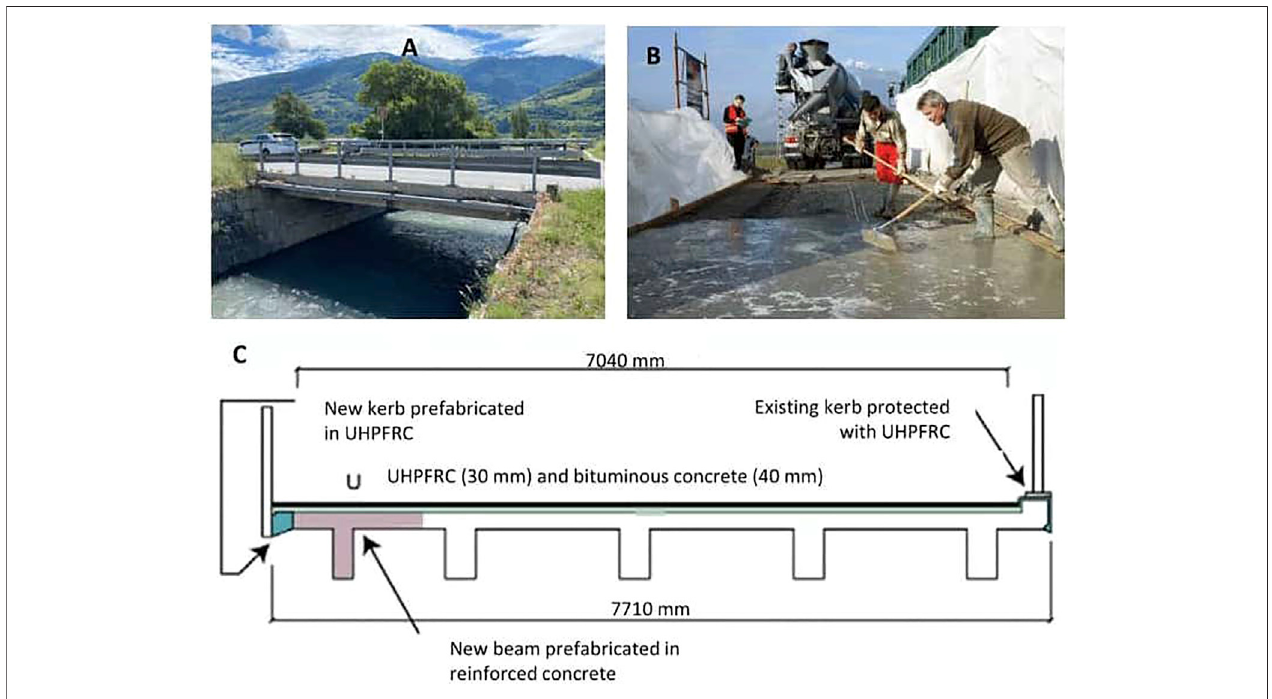
FIGURE6| BridgeoverLaMorgeriver. (A) Photographofthebridge18 yearsaftertheintervention(PhotoN.Bertola); (B) UHPFRCpouring(PhotoA.Hertzog); (C) scheme of the intervention using UHPFRC.